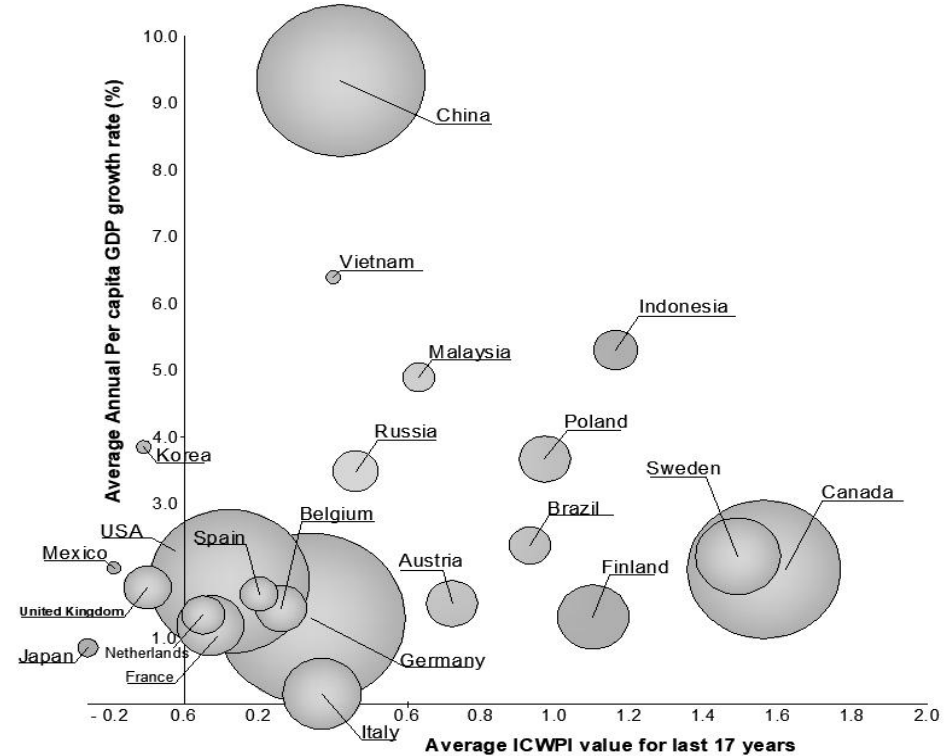
Figure 2. Average ICWPI index of selected countries for 2001–2017.